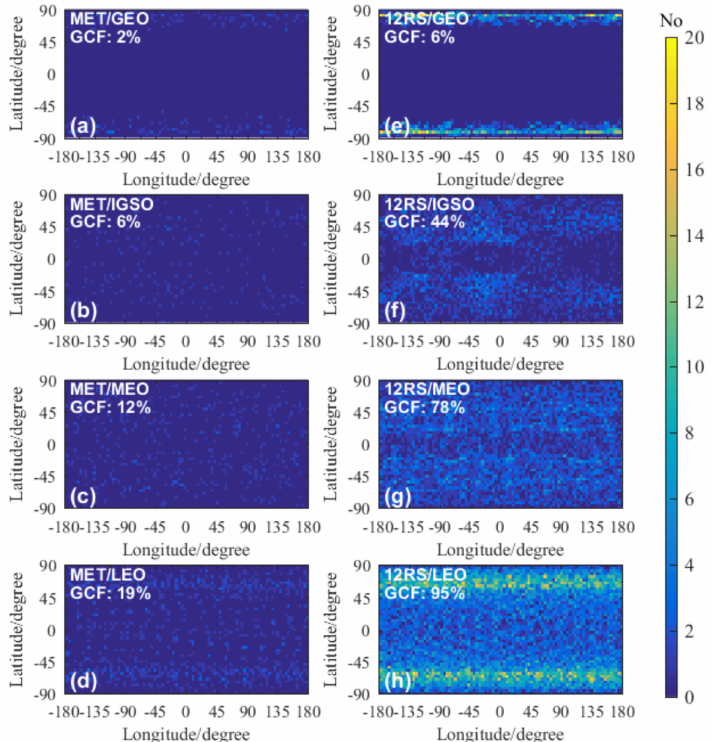
Figure 7. The global coverage of GNSS RO events for MET/GEO/IGSO/MEO/LEO and 12RS/GEO/IGSO/MEO/LEO RO systems, illustrating the number of RO event revisits using a 4 ◦ × 4 ◦ latitude and longitude grid